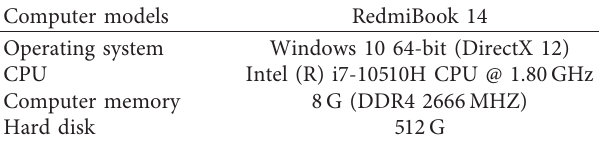
Table 5: Experimental test environment.